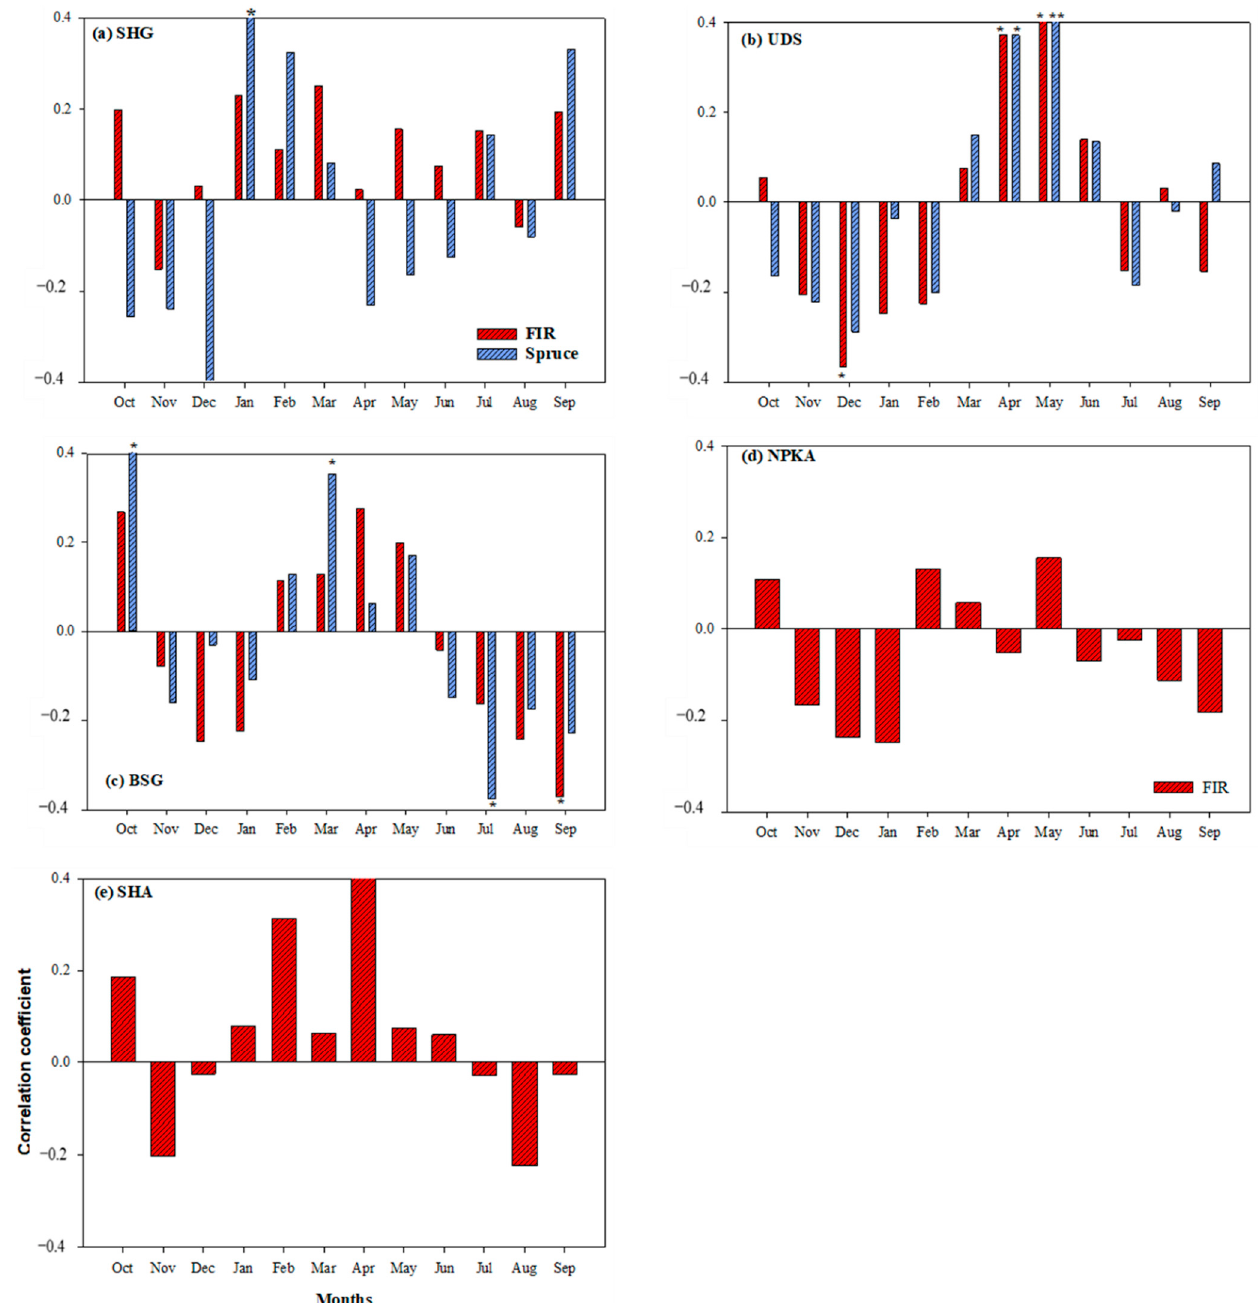
Figure 6. ( a – e ). Response function analysis between the tree-ring chronology of spruce (blue bar) and fir (red bar) and monthly total precipitation ( a – e ) during the period 1950–2018 at five sites (SHG, UDS, BSG. NPKA, and SHA) in Northern Pakistan. Stars indicate a significance level of p < 0.01.